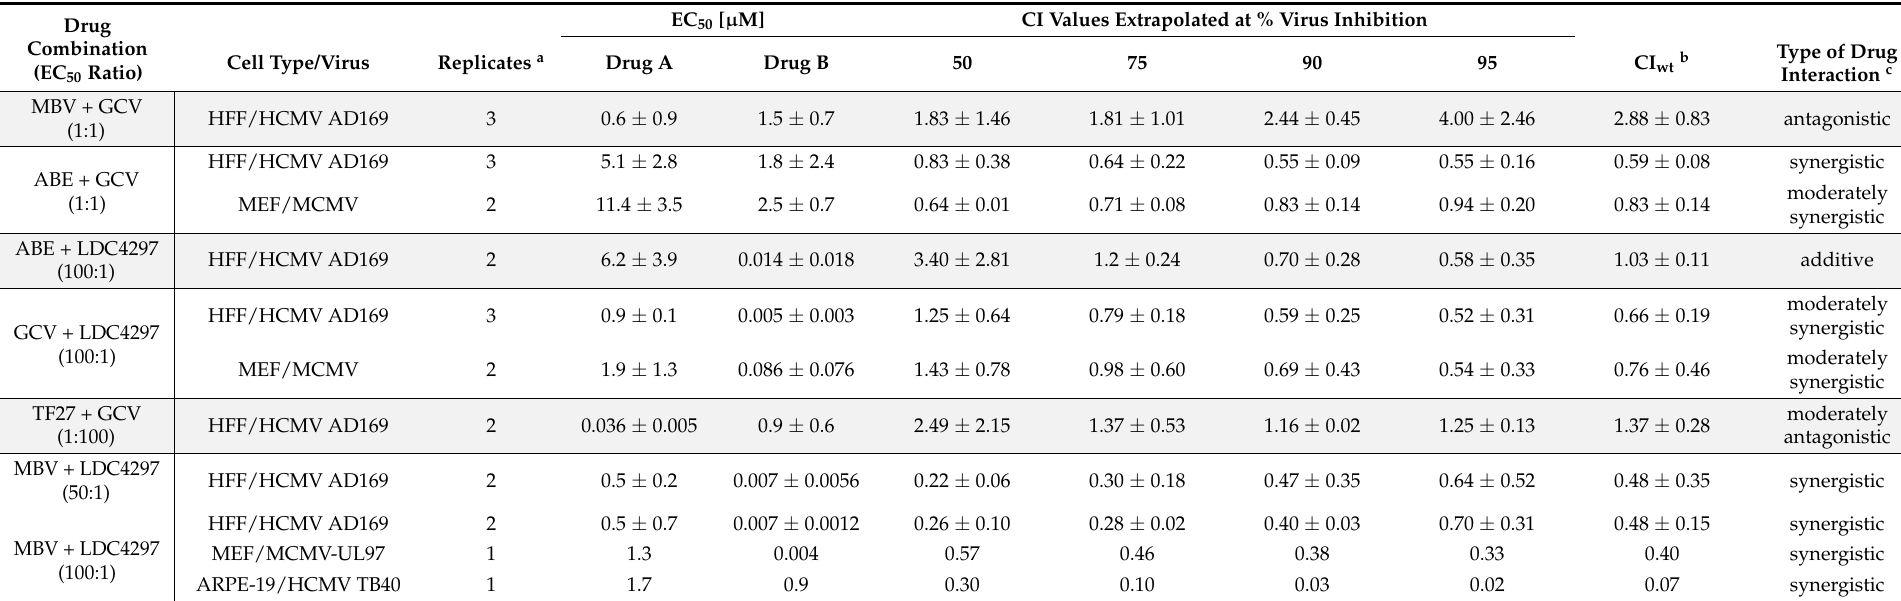
Table 3. Combinatorial anti-CMV drug assessment using the Loewe additivity fixed-dose